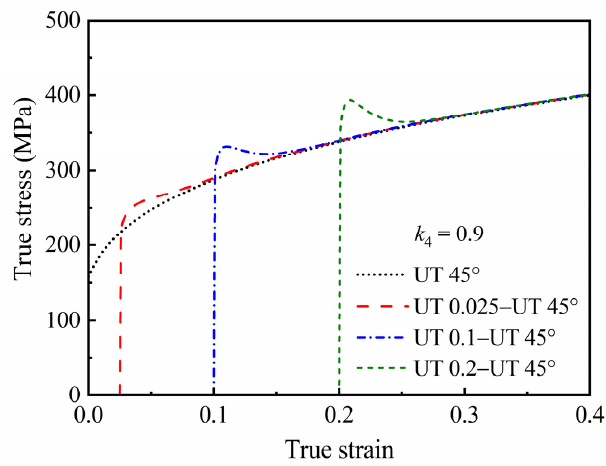
Figure 12. Stress–strain curves predicted by the HAH-2d model in two-step uniaxial tensions with tensile axes at 45° from each other.